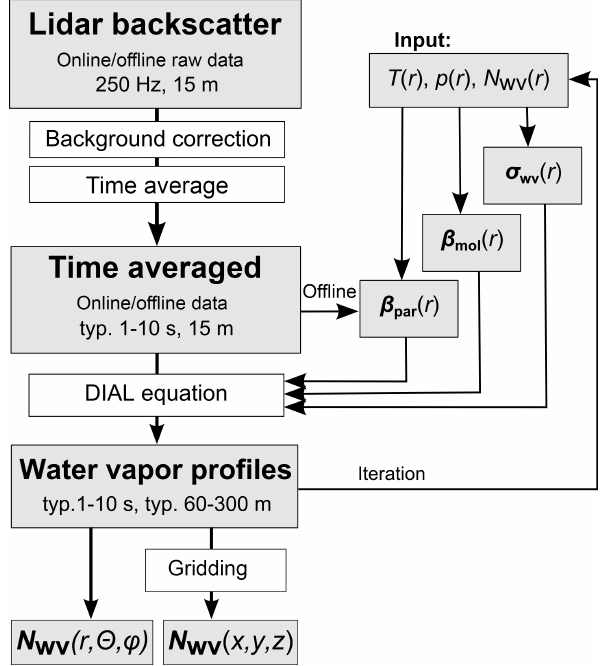
Figure 2. Flow chart of data processing. The backscatter coeffi- cients β par (r) and β mol (r) are only used if the Rayleigh Doppler correction (Eq. 4) is required. For the cases presented here, we used the Schotland approximation (Eq.